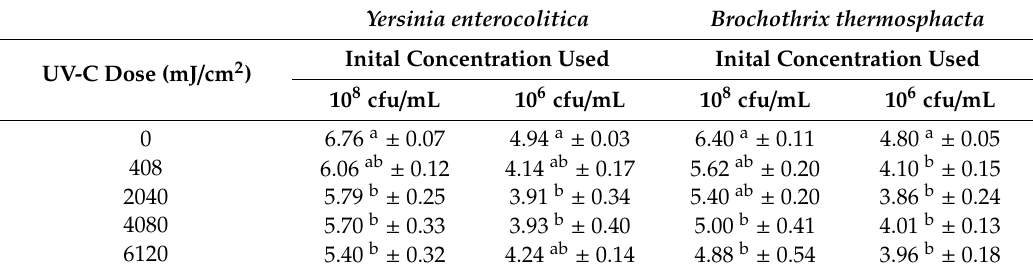
Table 3. Mean and standard error values of the bacterial counts of Yersinia enterocolitica ( n = 5) and Brochothrix thermosphacta ( n = 3) on ham after ultraviolet (UV)-C irradiation depending on the initial bacterial concentration. Yersinia enterocolitica Brochothrix thermosphacta Inital Concentration Used Inital Concentration UV-C Dose (mJ / cm 2 )